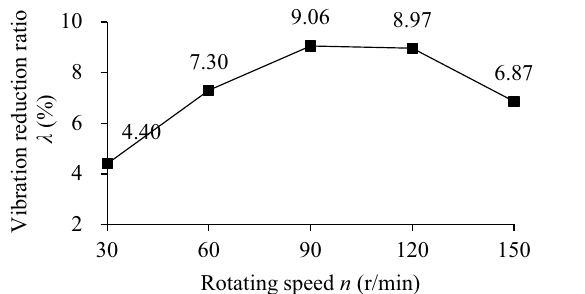
Figure 23. Influence of n on VRR.